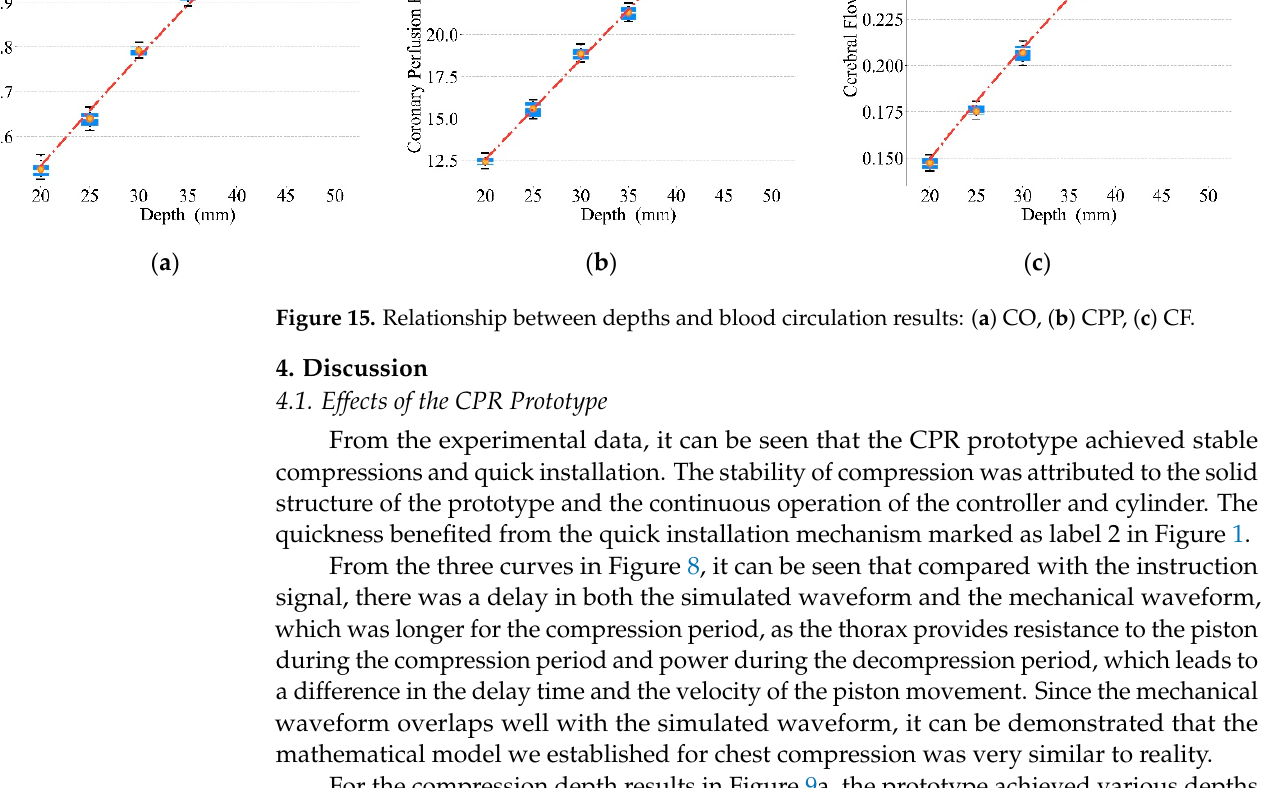
Figure 14. Relationship between duty cycles and blood circulation results: ( a ) CO, ( b ) CPP, ( c ) CF.